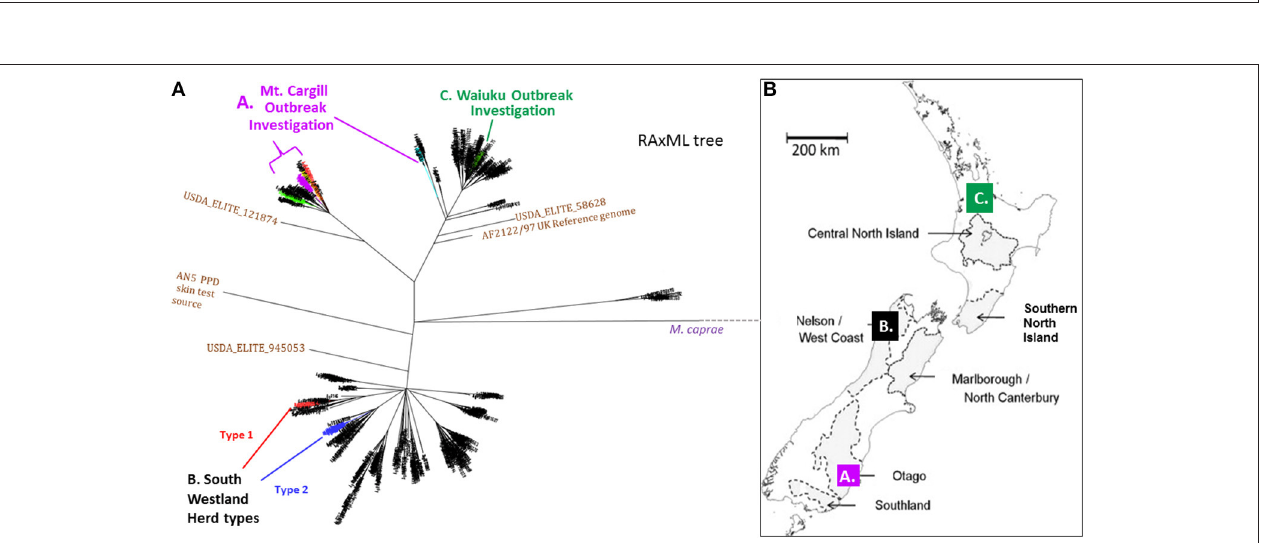
FIGURE 2 | (A) NZ M. bovis Radial ML Phylogram illustrating the Phylogenetic relationship of the isolates that will be discussed in more detail below. (A) Mt. Cargill investigation isolates-These isolates cluster in the Otago clade and are colored the same as in the boxed sub-groups in Phylogram in Figure 3a . (B) South Westland breakdown types- The two types isolated from the herd in South Westland and the closest relatives (shown in SNP tables in Figure 4B ) are colored differently; the breakdown type 1 isolate clusters in the VNTR53 group and it and its closest known relatives are colored red, the breakdown type 2 isolates clusters in the VNTR59 subgroup and it and its closest known relatives are colored blue. (C) Waiuku outbreak- isolates cluster in the CNI clade and outbreak isolates described in the SNP table in Figure 6B are colored green. (B) Map of NZ indicating vector risk areas (shaded regions) and illustrating geographical source of the isolates from the three outbreak investigations described below. Colored squares on the map indicate the regions of the discussed outbreak investigations. The three different investigations that will be discussed below are indicated by letters and color in the Phylogram in (A) and the map in (B) .